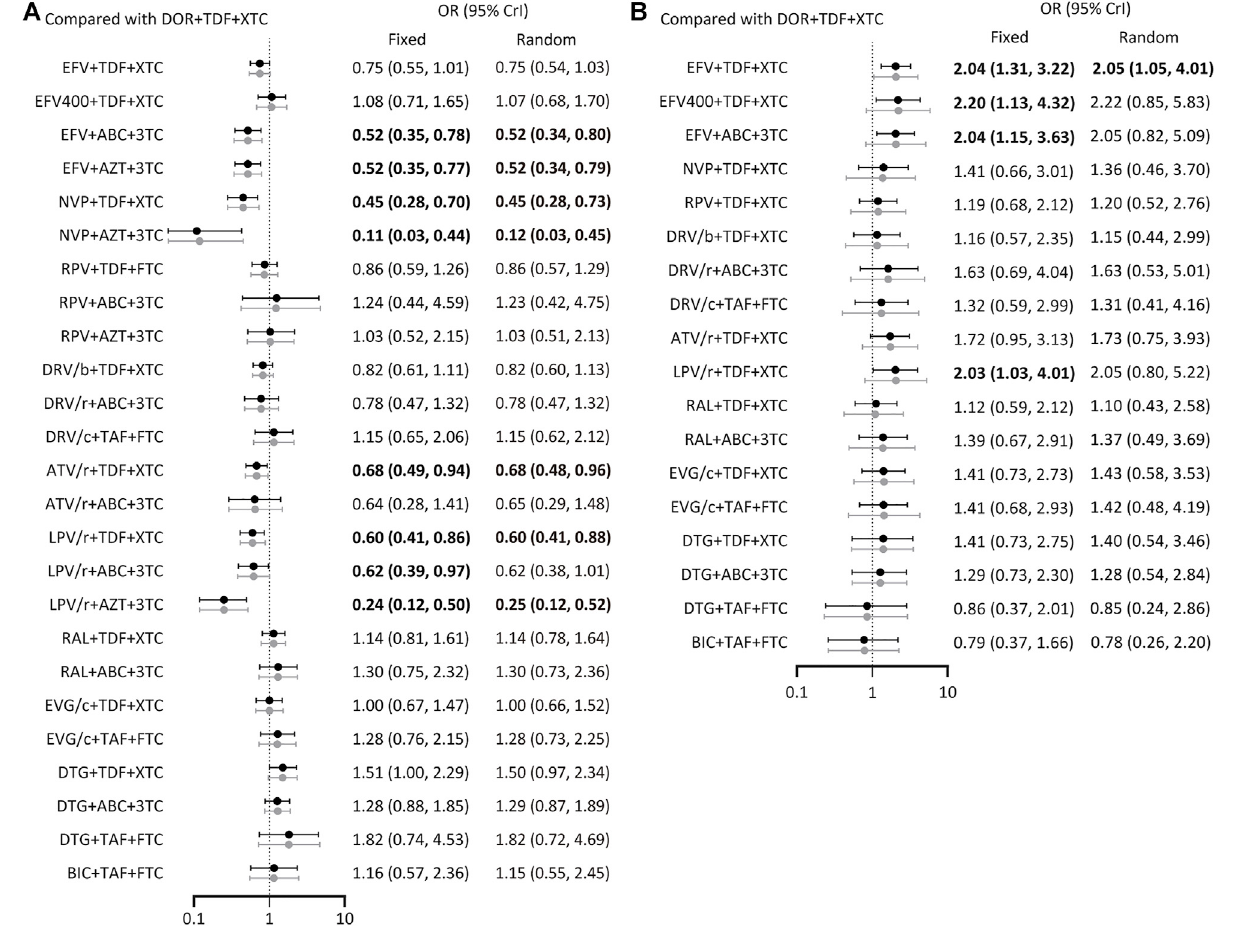
Frontiers in Pharmacology |